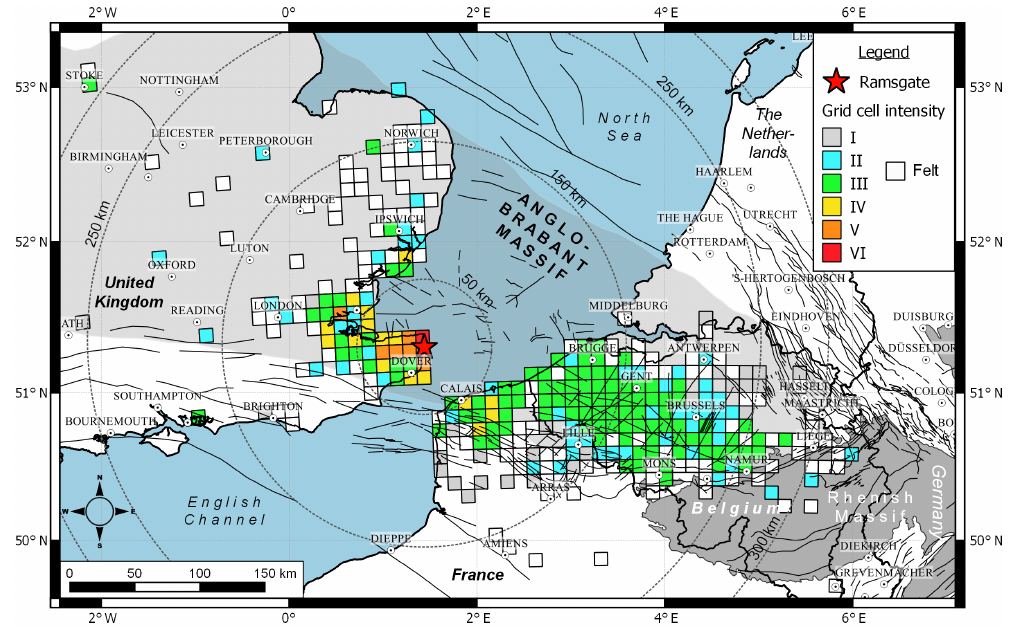
Figure 10. Grid cell intensity map of the 2015 Ramsgate earthquake. UK grid cells are merged from BGS, EMSC and USGS data. Cells on the continent result from merged macroseismic data from the ROB-BNS, EMSC and BCSF agencies. Note the particular WNW–ESE elongated distribution following the structure of the Anglo-Brabant Massif (indicated in grey). Grid cell size is 100km 2 . “Felt” cells contain less than three